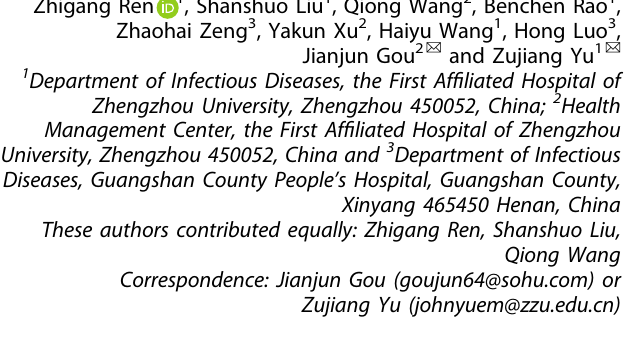
Fig. 1 Alterations of the oral and gut mycobiome and cytokines of COVID-19 convalescents after 1-year follow-up. a As estimated by the Shannon index, the α diversity of oral mycobiome gradually increased. b As estimated by the Simpson index, the α diversity of gut